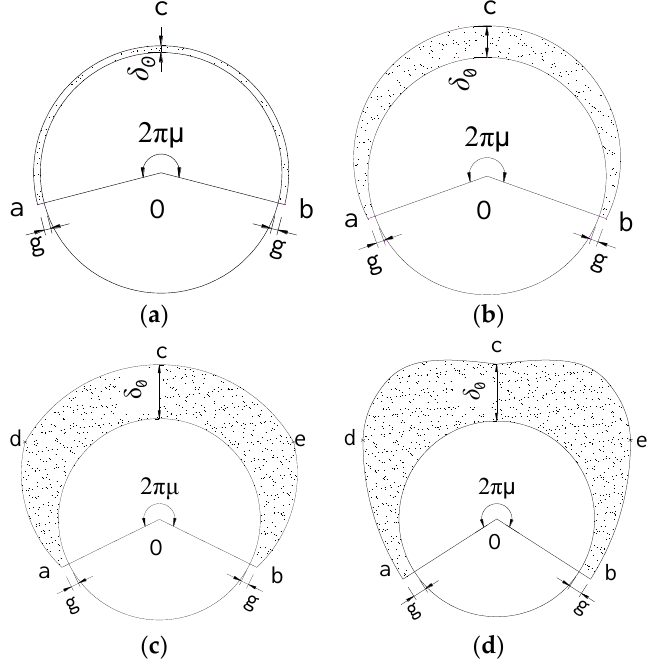
Figure 14. Engineering geometric models of radial ice: ( a ) annular shaped, ( b ) crescent shaped, ( c ) sector shaped, and ( d ) D shaped.